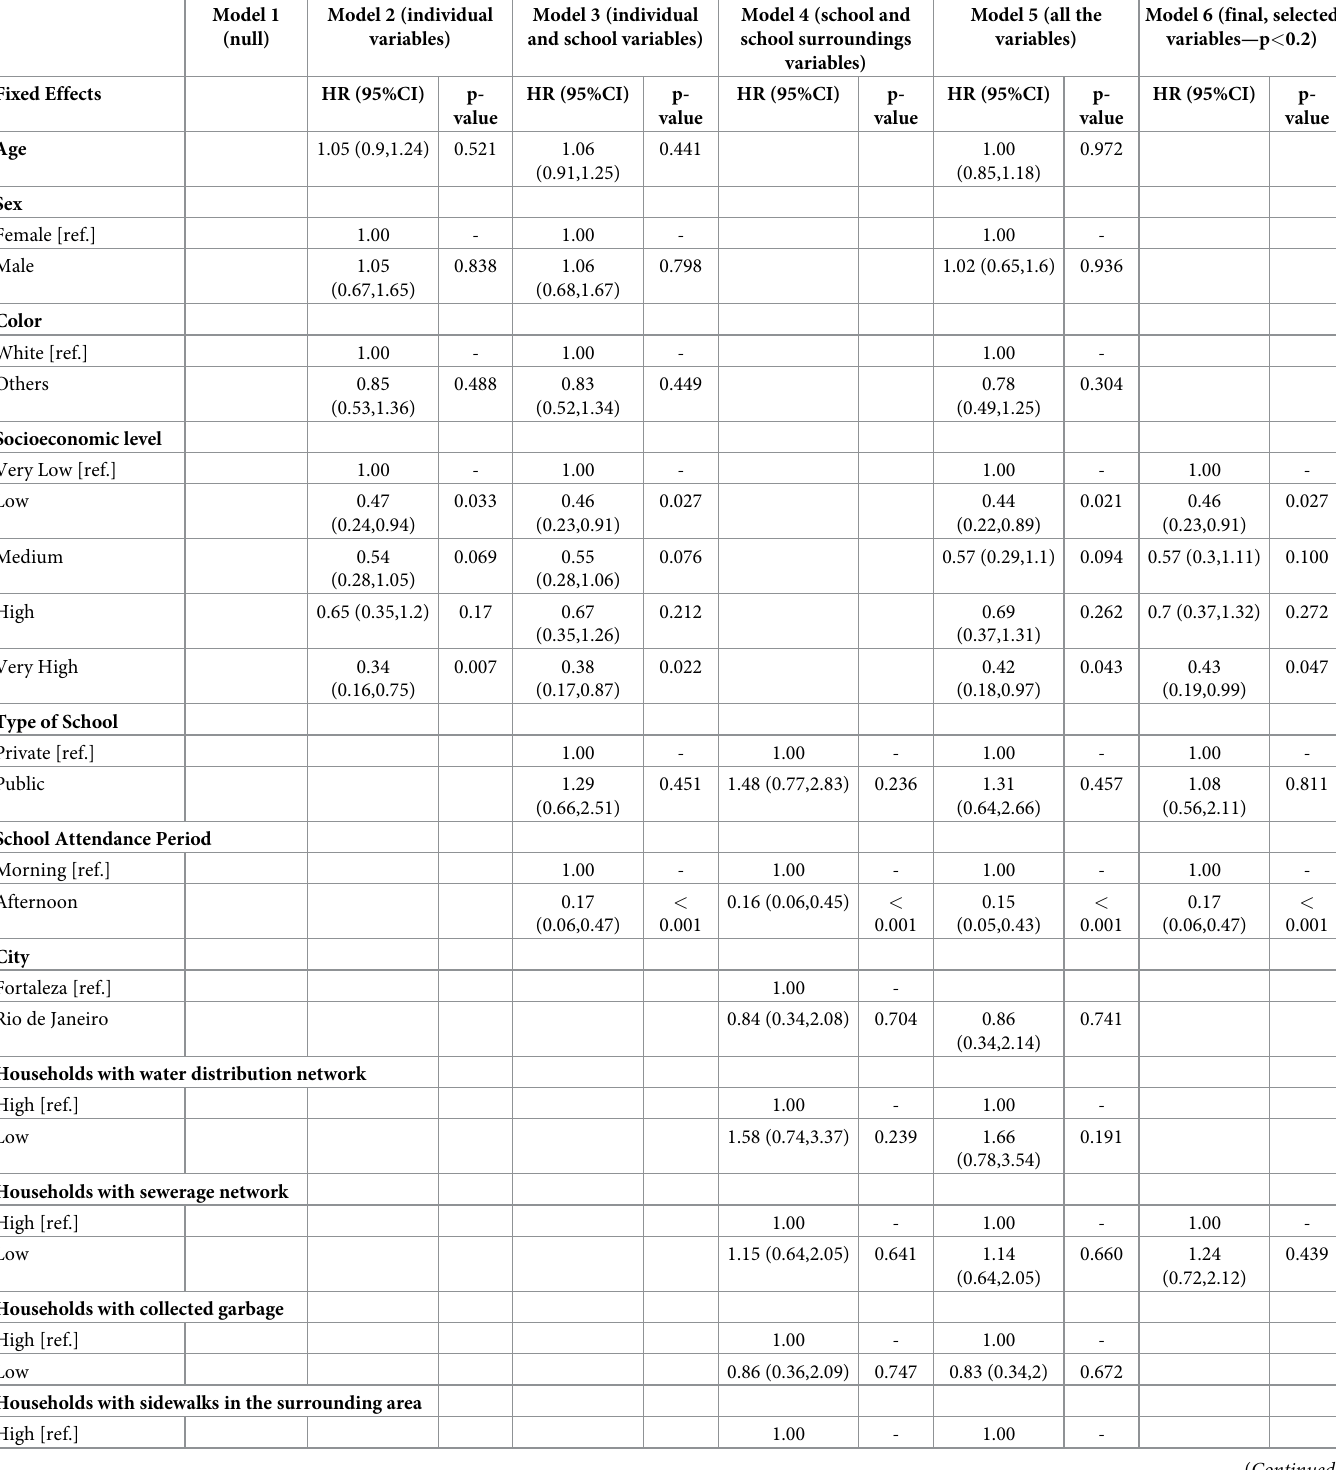
Table 3. Measures of association (hazard ratios) obtained by multivariate Cox proportional hazards regression between arboviral diseases, socioeconomic/demo- graphic characteristics and school characteristics of adolescents followed up by ERICA in the cities of Rio de Janeiro and Fortaleza, Brazil, from January 2015